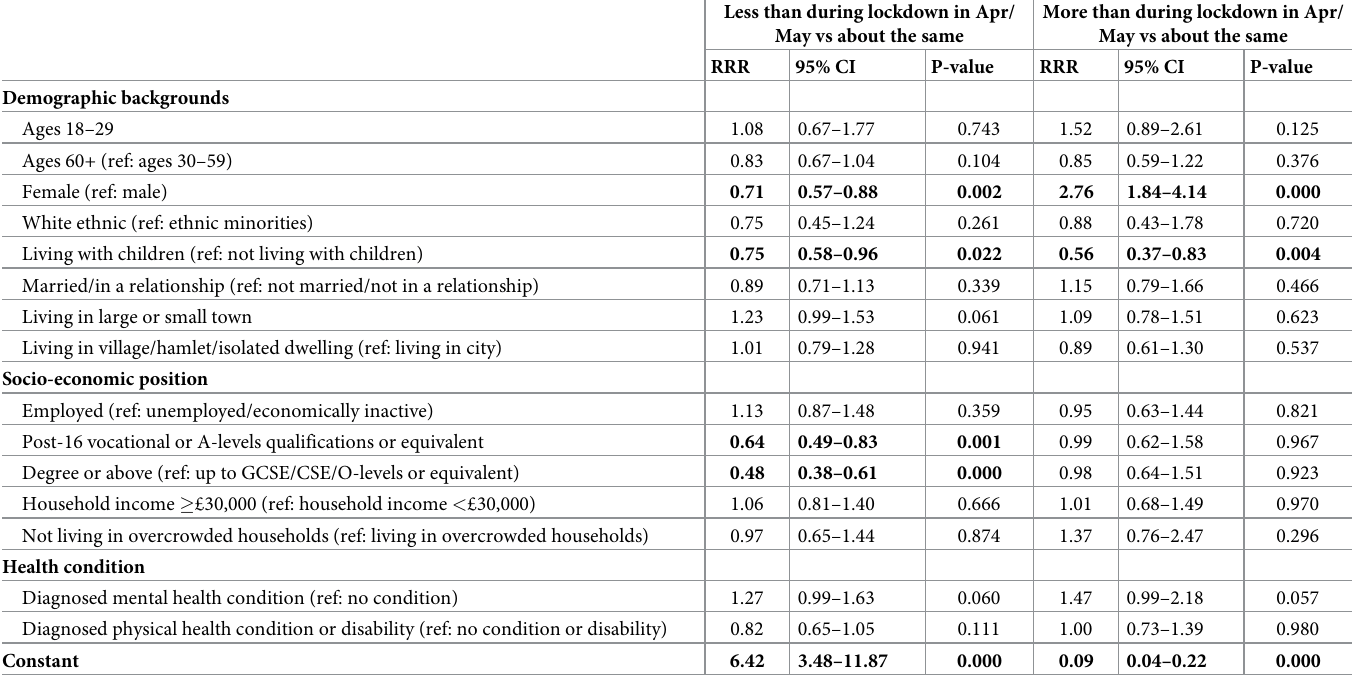
Table 3. Multinomial logistic regressions comparing arts engagements in the second lockdown (November/December 2020) with engagements in the first lockdown in April/May (2020) (N = 11,481).